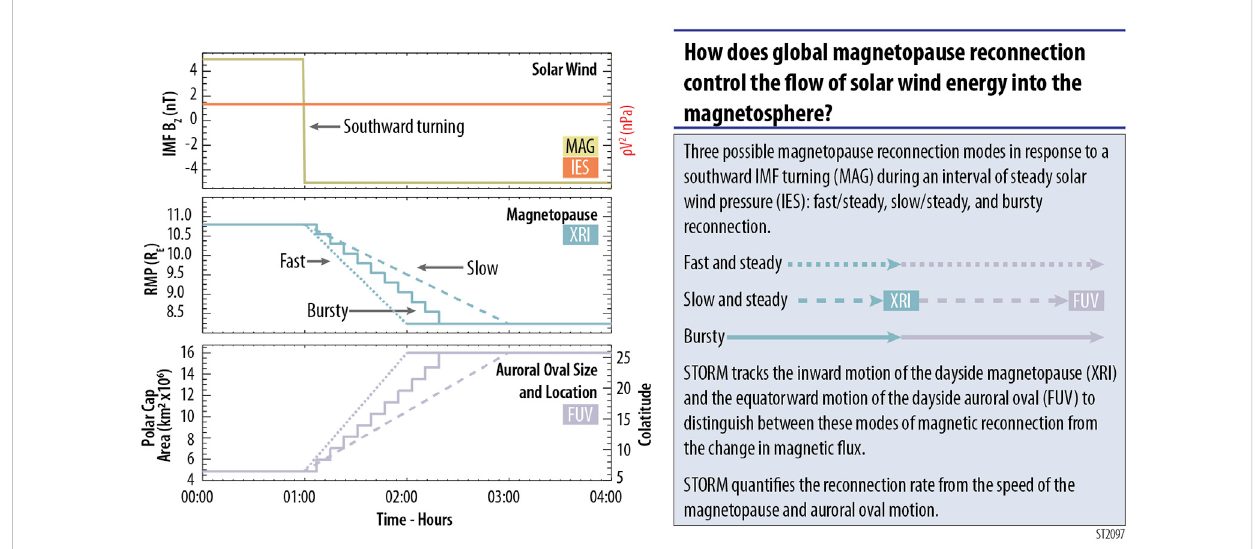
FIGURE 3 An illustrative example of how STORM addresses part of science objective A using observations from MAG, IES, XRI and FUV. Left, a southward turning oftheIMF(top) initiatesdaysidereconnection,intheabsenceofnightsideactivity,themagnetopause movesinward(middle)and theauroral oval moves equatorward expanding the polar cap area (bottom). Right, a description of how STORM differentiates between proposed reconnection